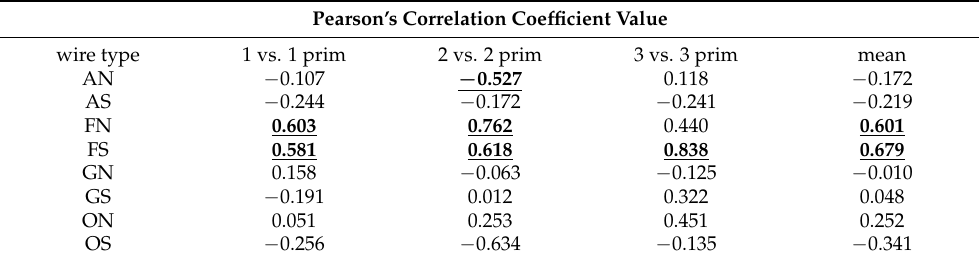
Table 2. Pearson’s correlation coefficient value between each side of the wire.